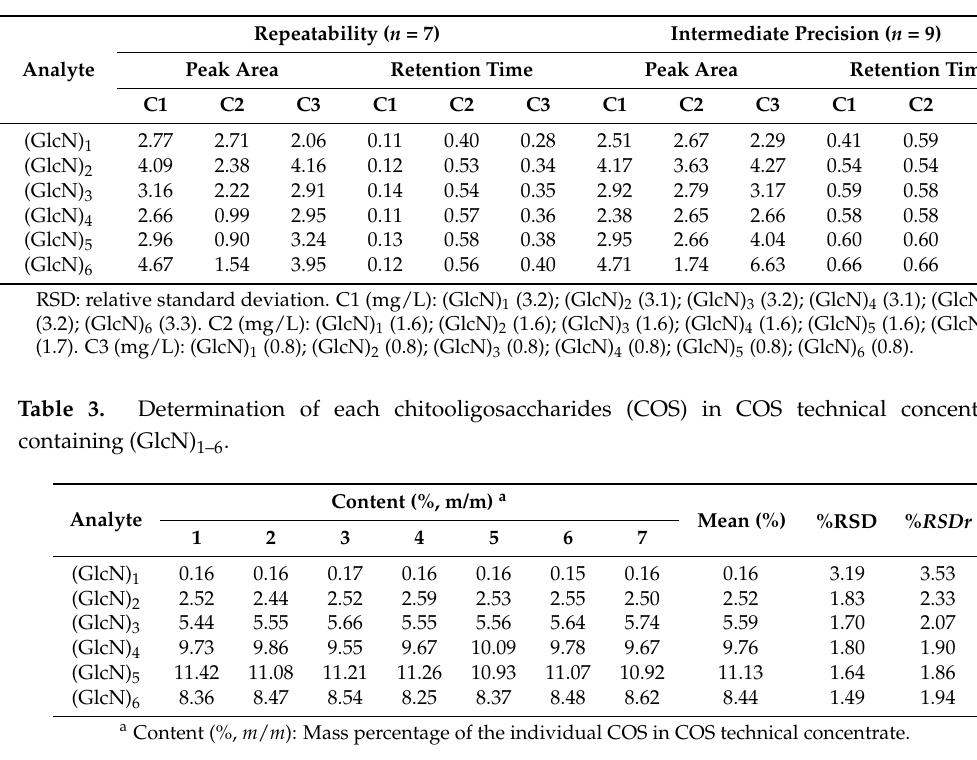
Table 4. Method accuracy for determining each COS in COS technical concentrate containing (GlcN) 1–6 .